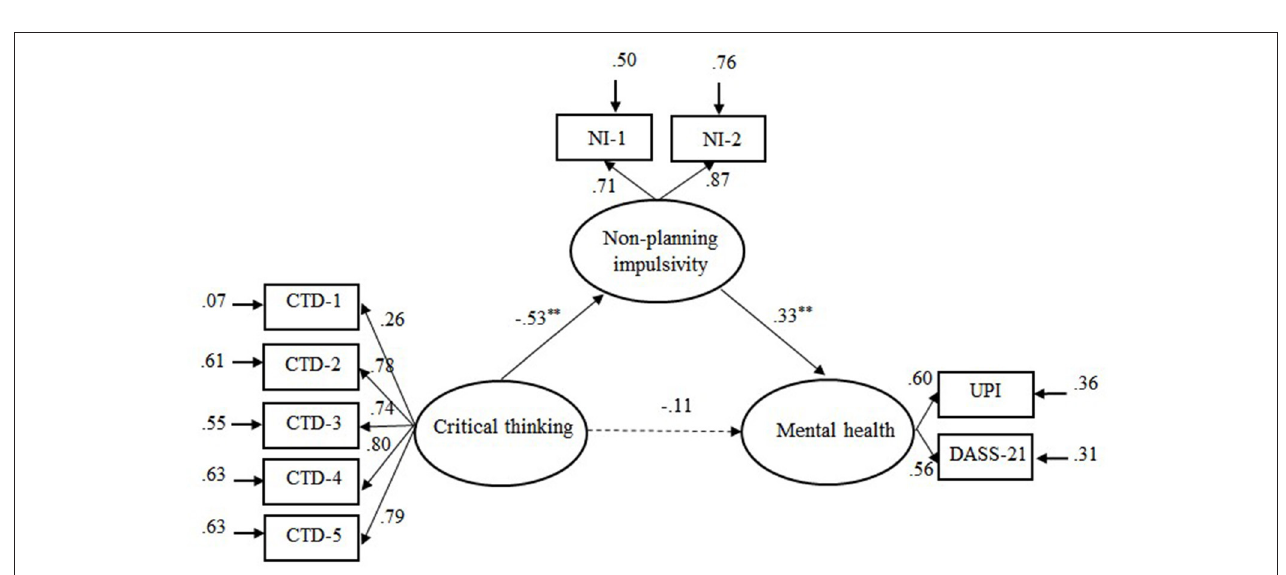
FIGURE 2 | Illustration of the mediation model: Non-planning impulsivity asmediator variable between critical thinking dispositions and mental health. CTD-l = Truth seeking; CTD-2 = Analyticity; CTD-3 = Systematically; CTD-4 = Self-confidence; CTD-5 = Inquisitiveness. NI-I and NI-2 were sub-scores of Non-planning impulsivity. Solid line represents significant links and dotted line non-significant links. ** p <